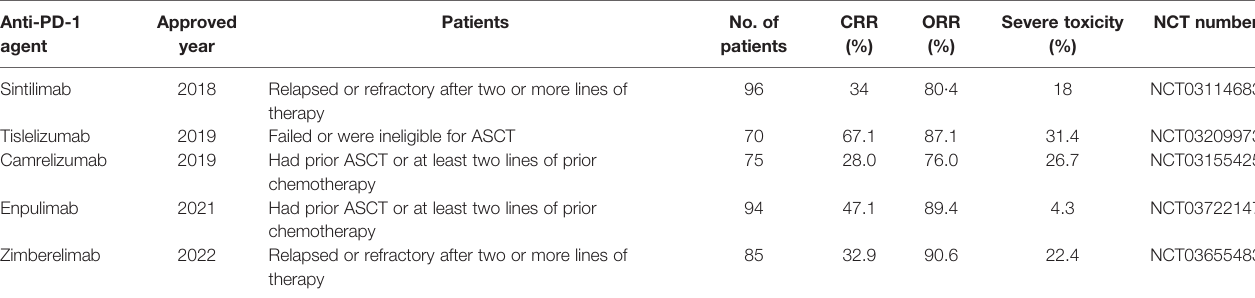
TABLE 2 | Anti-PD-1 antibodies approved by the National Medical Products Administration in China for r/r cHL. Anti-PD-1